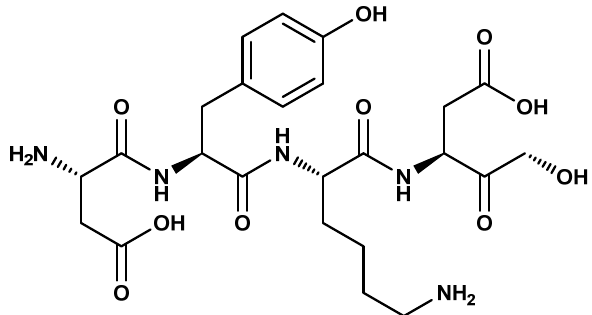
Figure 11. Scheme DYKD peptide used as template molecule.